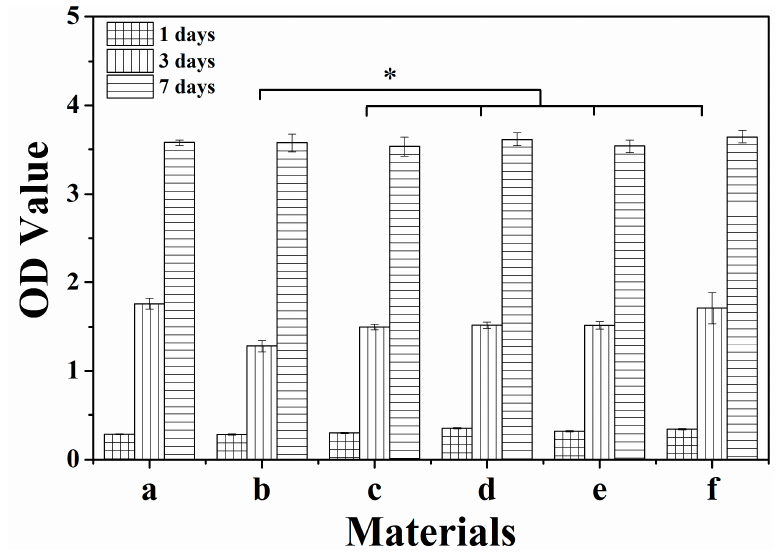
Figure 12. Cell proliferation histogram of MC3T3-E1 cells cultured on (a) glass, (b) PLGA, (c) GdPO 4 · H 2 O/PLGA, (d) GdPO 4 ·H 2 O@SiO 2 /PLGA, (e) GdPO 4 ‧ H 2 O@SiO 2 –APS/PLGA and (f) PBLG-g- (c) GdPO 4 · H 2 O/PLGA, (d) GdPO 4 · H 2 O@SiO 2 /PLGA, (e) GdPO 4 · H 2 O@SiO 2 –APS/PLGA and GdPO 4 ·H 2 O/PLGA for 1, 3 and 7 days. * p < 0.05. (f) PBLG-g-GdPO 4 · H 2 O/PLGA for 1, 3 and 7 days. * p <